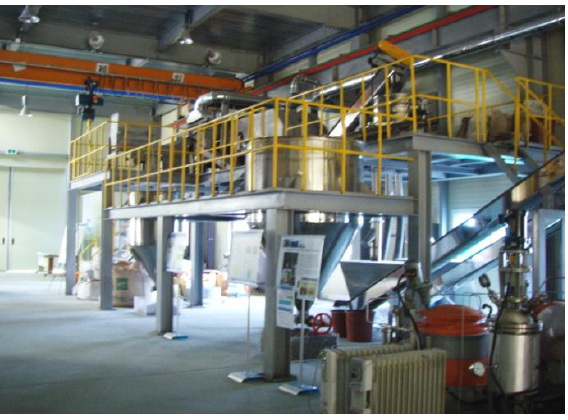
Figure 5. A pilot plant equipped with multi-processes for the recycle of municipal solid waste incineration (MSWI) ash in Korea Institute of Geoscience and Mineral Resources (KIGAM), South Korea (unpublished